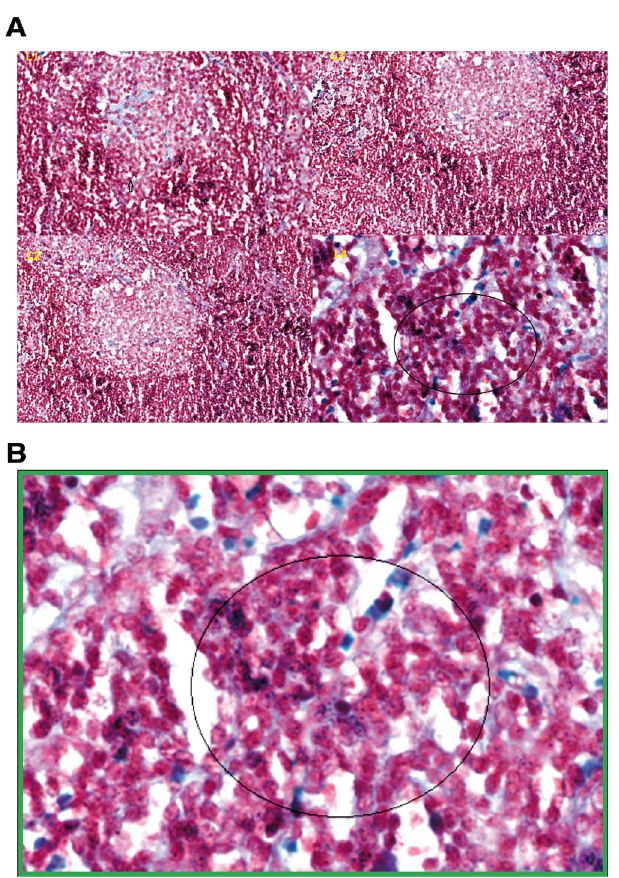
Figure 6. Human lymph node histochemistry. ( A ) Gram positive granules were absent in the germinal centres L1, L2, L2. Gram positive granules were specifically detected in the paracortex, outside the germinal centres, L4. ( B ) The picture with the green frame is L4 at higher magnification (×80) with blue granules in the